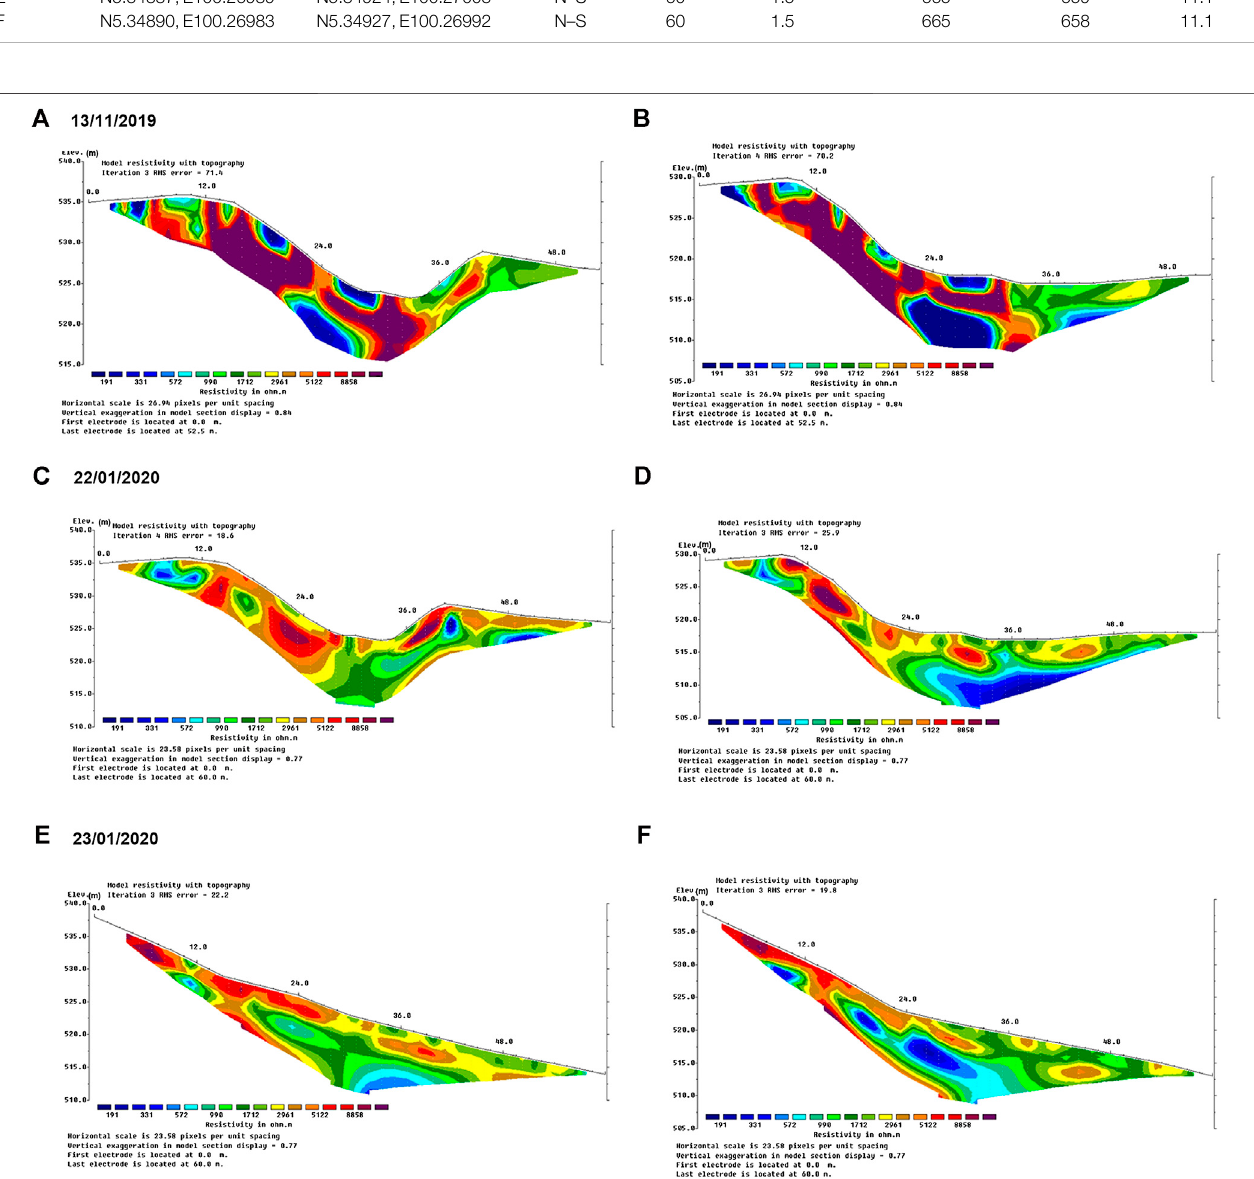
FIGURE 6 | Model results of the acquired electrical resistivity tomography data at different dates using Wenner – Schlumberger array con fi guration: (A,B) pro fi les in east – west direction on November 13, 2019; (C,D) pro fi les in east – west direction on January 22, 2020; and (E,F) pro fi les in north – south direction on January 23, 2020.